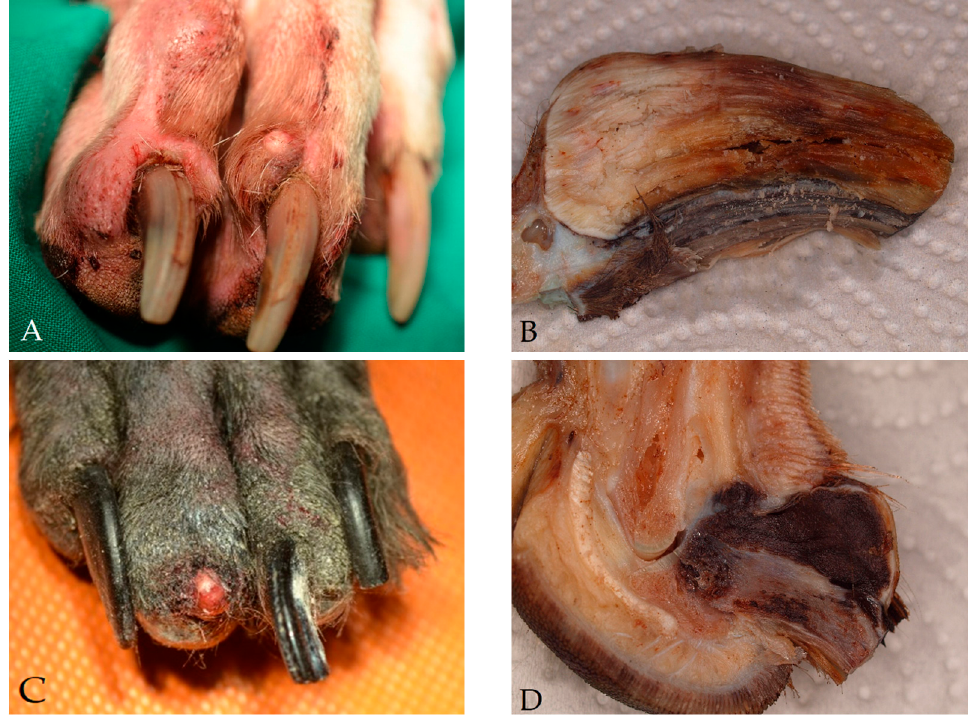
Figure 2. Distribution of non-neoplastic lesions, tumor-like lesions, and neoplasms in digital samples of the most common breeds (more than 50 dogs per breed).